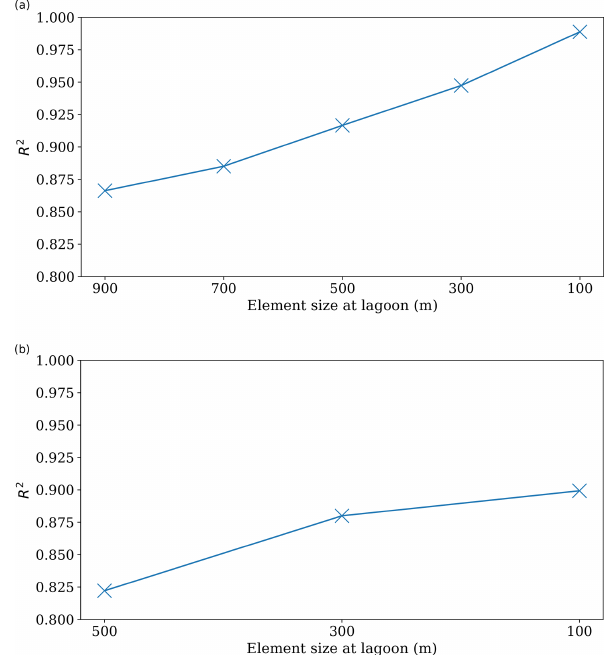
Figure 4. (a) Correlation between bathymetry interpolated onto mesh and the original high-resolution bathymetry dataset for dif- ferent element sizes at lagoons. (b) Correlation between simulated tidal amplitudes and corresponding tide gauge data for the meshes identified in (a) that achieved R 2 > 0 .